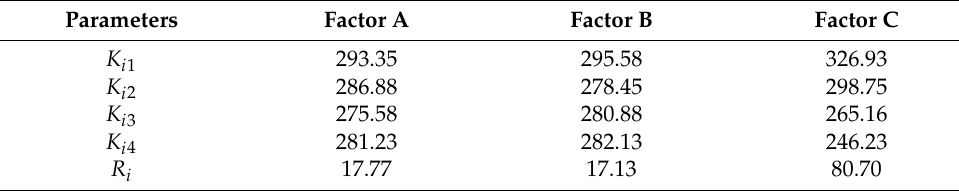
Table 8. Range analysis results for Nusselt number.